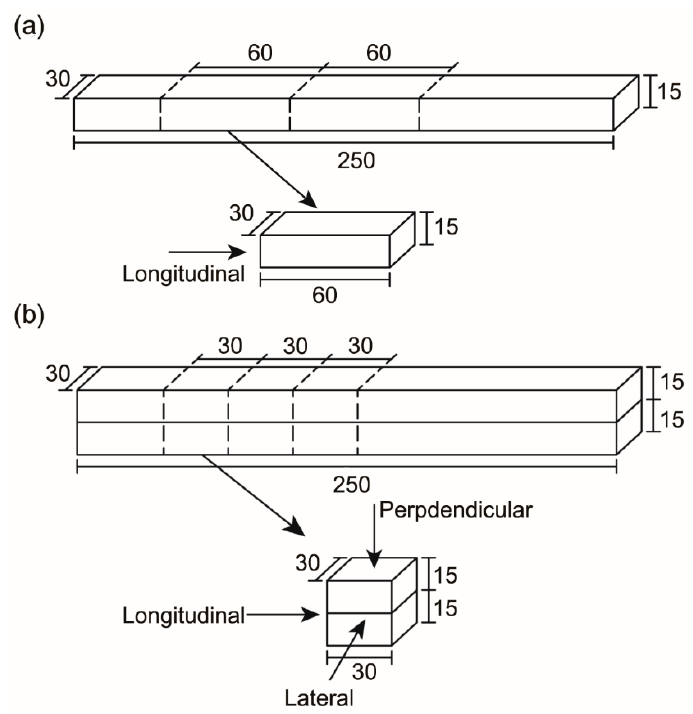
Figure 4. Dimensions and testing directions for the compression test of ( a ) the 3D printed one-layer specimen and ( b ) the 3D printed two-layer specimen.